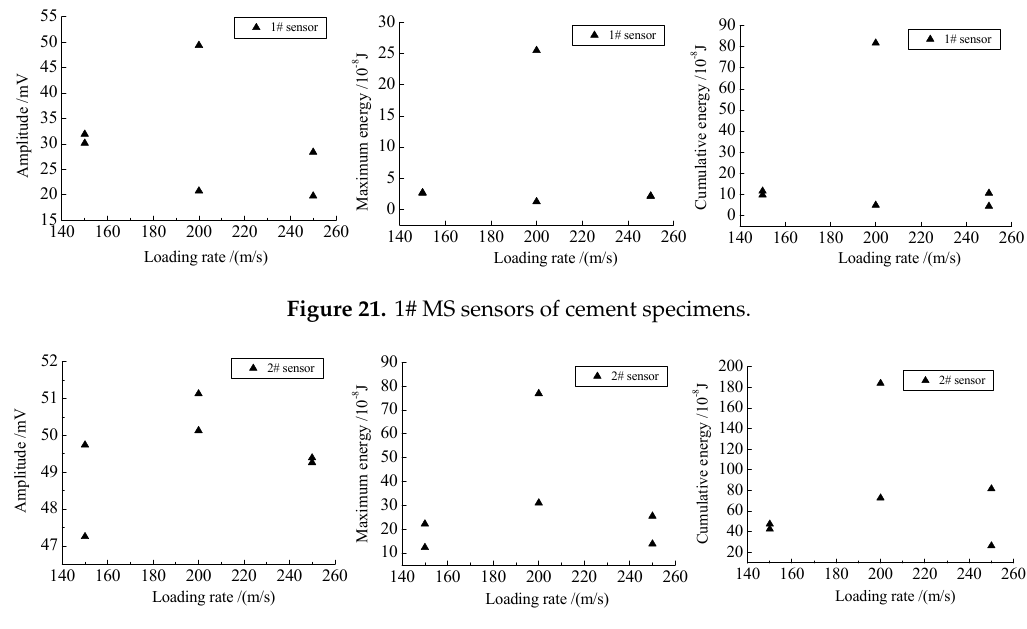
Figure 22. 2# MS sensors of cement specimens.